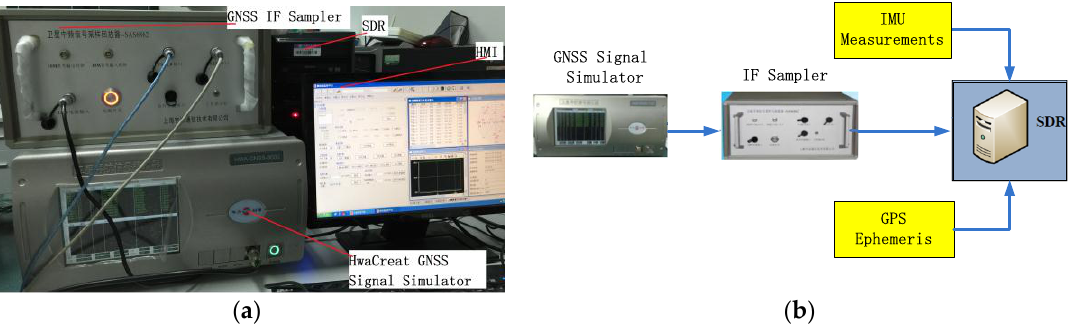
Figure 7. The distribution and connection of the instruments in the experiment. ( a ) Physical connection; and ( b ) schematic connection.